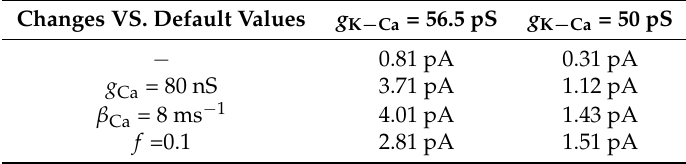
Figure 4. Bifurcation diagrams of the model in the presence ( left ) and absence ( right ) of tonic NMDA current. Gray and black lines indicate steady states and oscillatory solutions, respectively. In the latter case, the two branches represent the minimal and maximal values of voltage reached during oscillations. Plain lines represent stable solutions and dashed lines, unstable ones. In the presence of tonic NMDA activity, a stable state coexists with stable oscillations in an extended range of values for the injected current (shaded area). Sub-critical Hopf bifurcations occur at 11.5 pA ( left ) and 1.4 pA ( right ). Table 1. Ranges of values of the injected current ( I inj ) allowing bistability for different values of parameters affecting the concentration of cytosolic calcium. For each parameter, the middle column indicates the range obtained with the default value of the maximal conductance of the I K − Ca current ( g K − Ca = 56.5 pS) and the right column indicates the range obtained with a reduced value of this maximal conductance ( g K − Ca = 50 pS). The values of the other parameters are listed in the Appendix A. Ranges of bistability are evaluated on the basis of bifurcation diagrams obtained as in Figure 4. Note that injected current intensities between 0 to 30 pA represent the realistic stimulus range for our